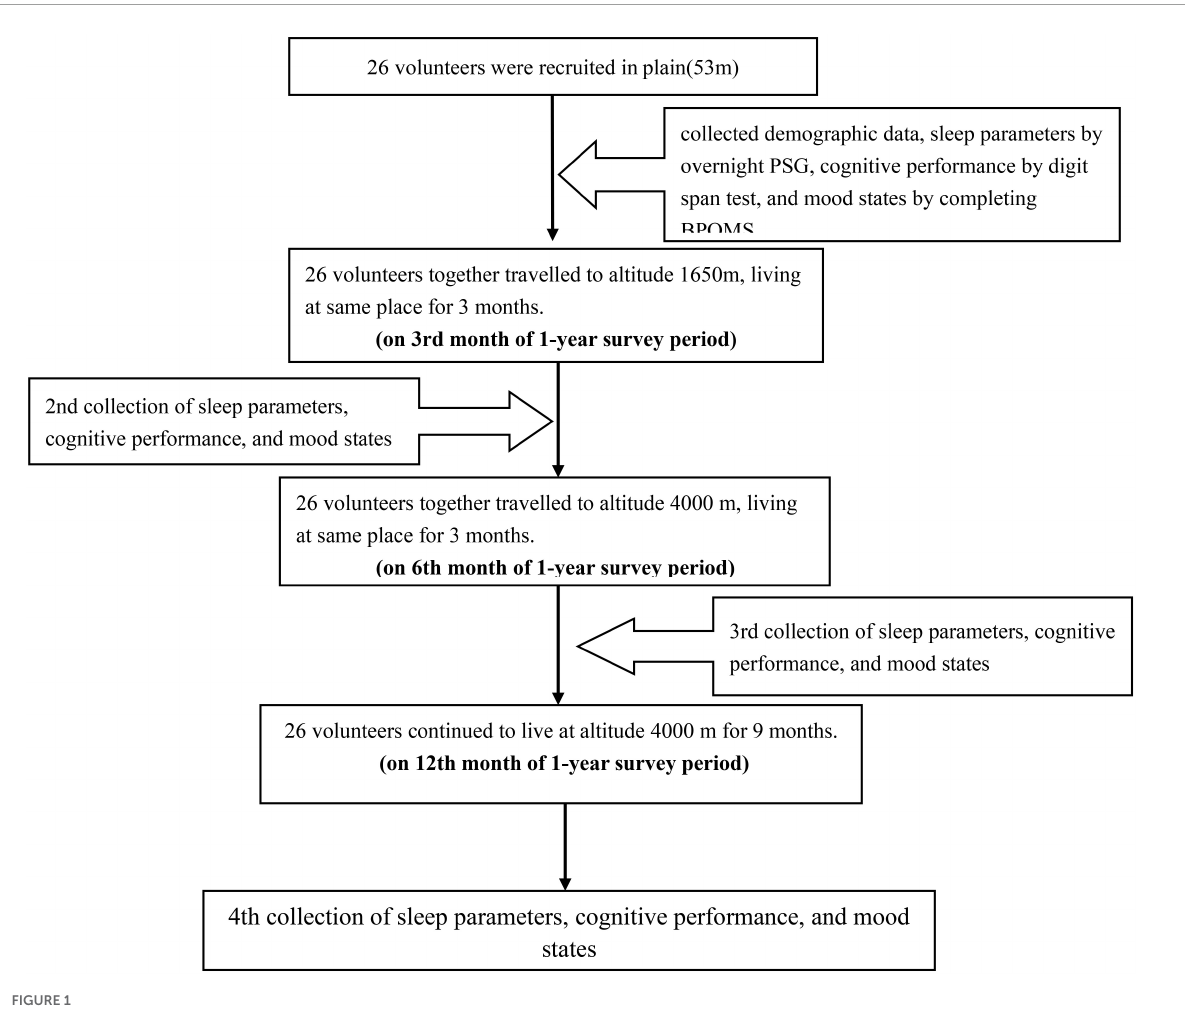
FIGURE1 Technology road map. PSG, polysomnography; BPOMS, brief profile of mood